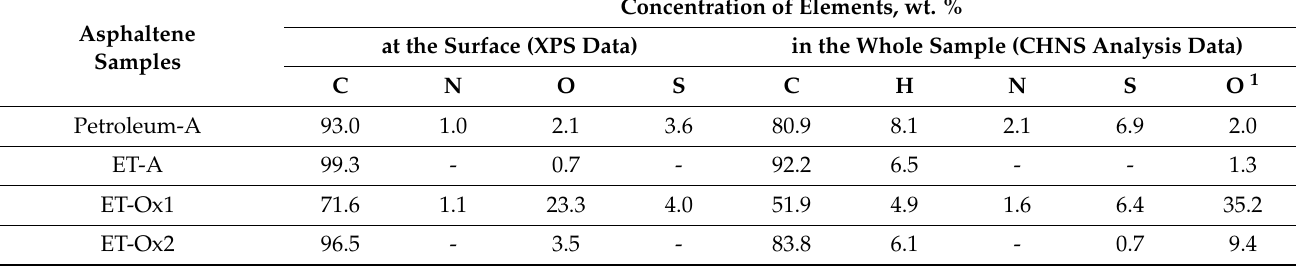
Table 1. Content of elements in asphaltene samples according to X-ray photoelectron spectroscopy (XPS) data (on the surface) and CHNS elemental analysis. Concentration of Elements, wt. Asphaltene